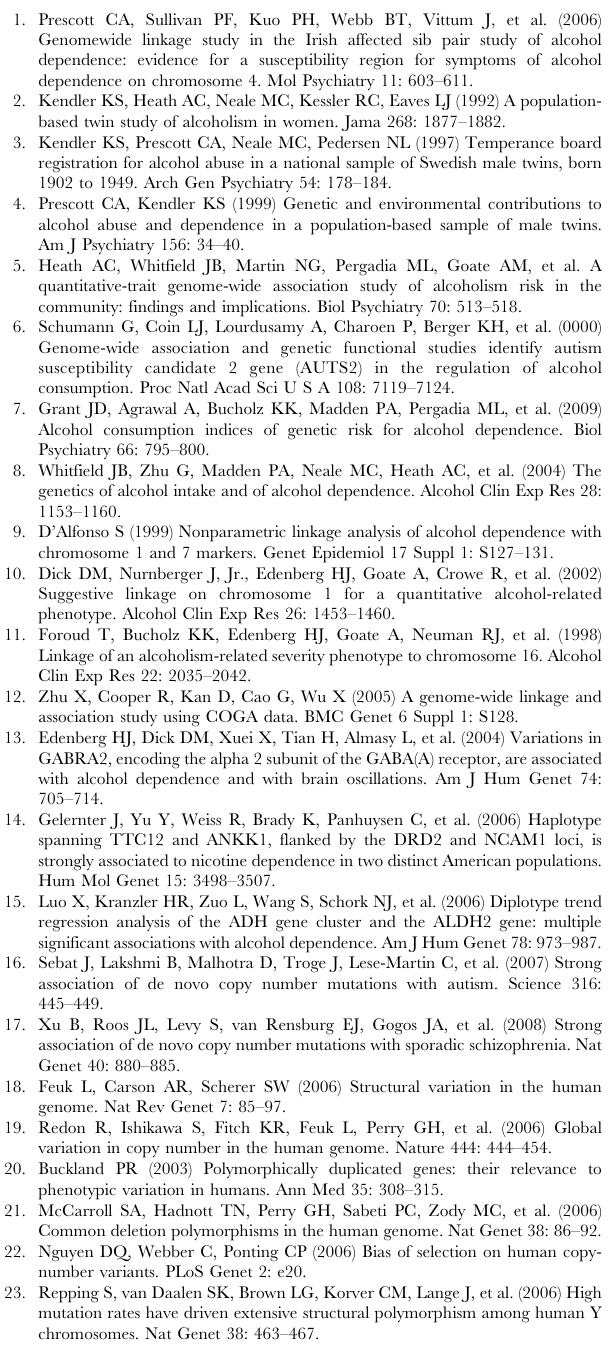
Table S1 Information of 30 CNVs with p , 0.05 in discovery